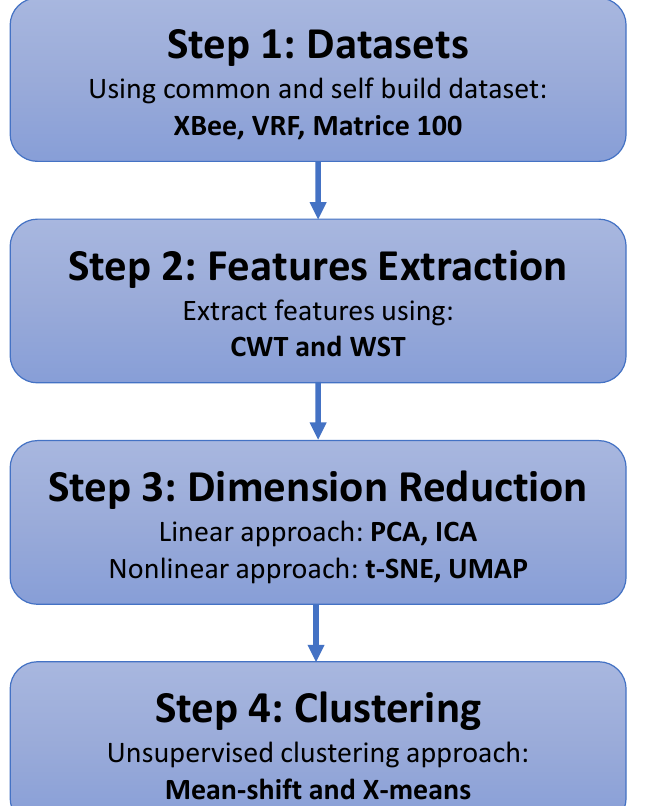
Figure 7. Flowchart of the proposed